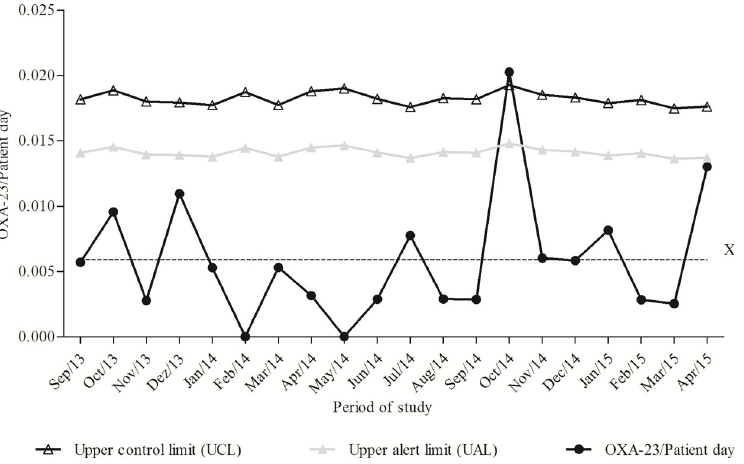
Fig 2. Temporal distribution of OXA-23-producing A . baumannii strains in the ICU per patient-days from September 2013 to April 2015. X centre line (average rate of OXA-23 infections per patient-days = 0.0058).